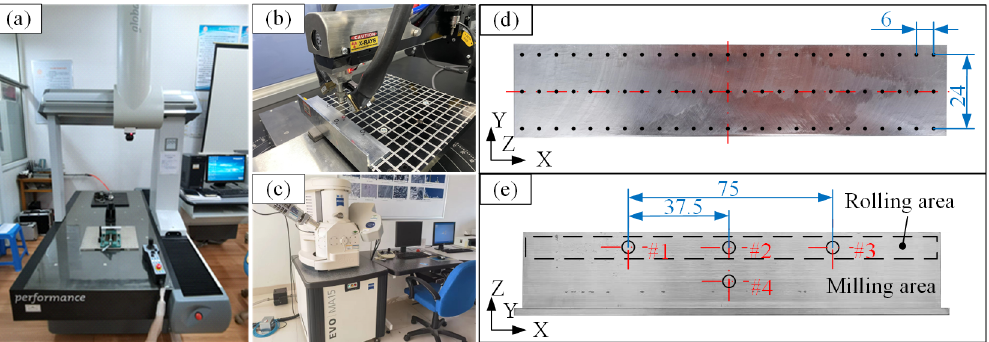
Figure 3. Measurement process of structural parts: ( a ) CMM tests, ( b ) residual stress detection, ( c ) SEM system, ( d ) CMM measurement point, and ( e ) residual stress measurement point. The cutting position of the sample used to observe the microstructure is shown in Figure 1. Two samples for microstructure analysis, 1 (cid:13) and 2 (cid:13) , were cut from each test sample by electrical discharge machining (EDM). The normal direction of the sections of samples 1 (cid:13) and 2 (cid:13) was parallel to the rolling direction. Sample 1 (cid:13) was located in the rolling area, and sample 2 (cid:13) was located in the milling area. Samples 1 (cid:13) and 2 (cid:13) were